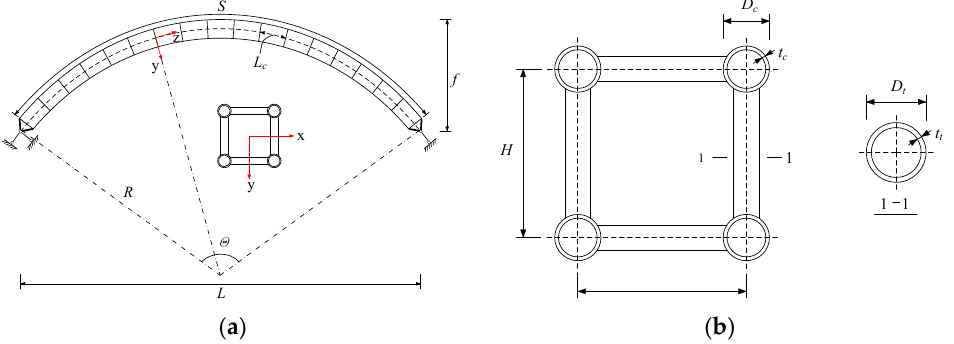
Figure 3. Geometric dimensions of a typical Vierendeel truss arch and its cross-section. ( a ) Global dimensions. ( b ) Cross-sectional dimensions.